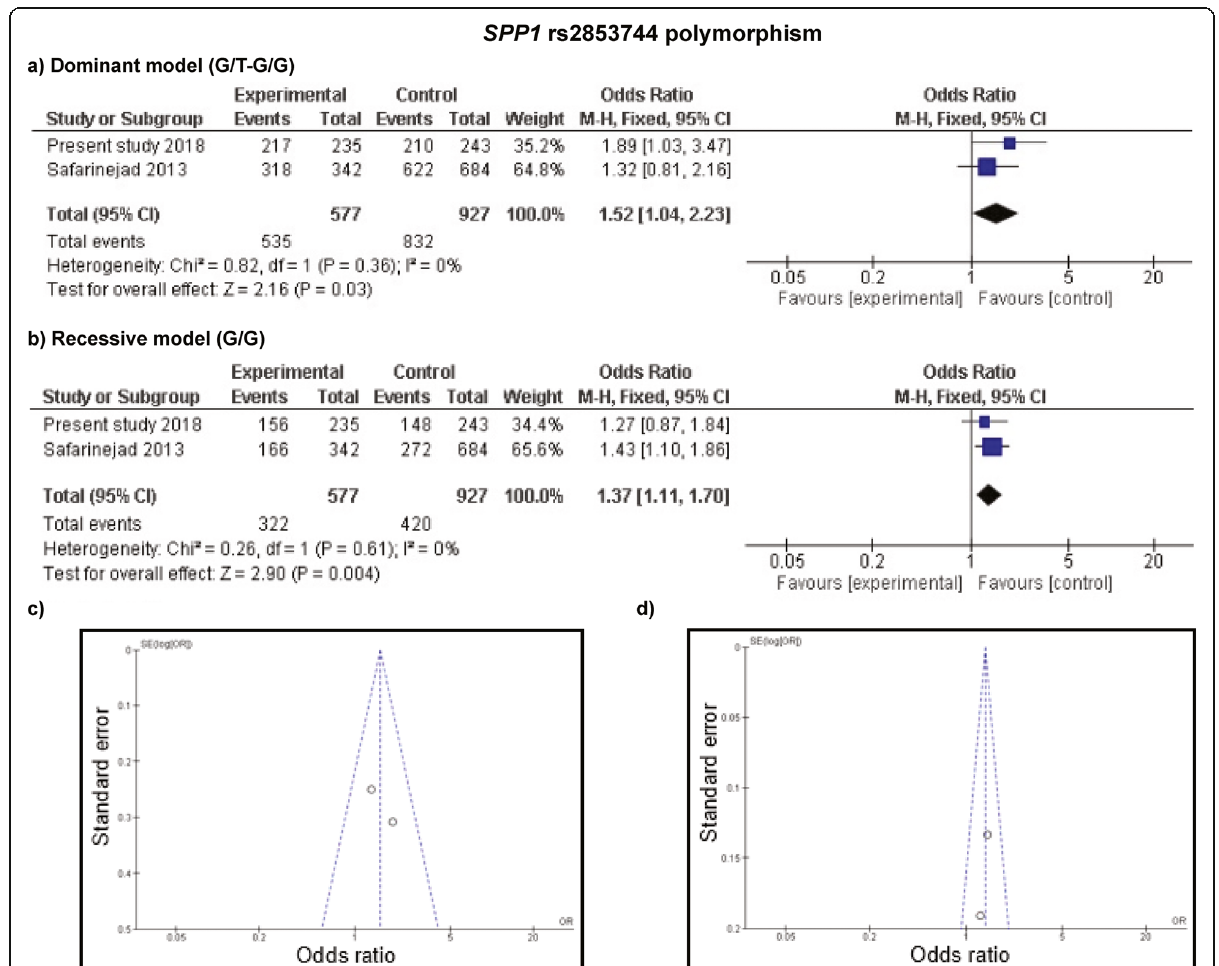
Fig. 2 Meta-analysis of SPP1 rs2853744:G > T polymorphism with risk of urolithiasis. a and b Forest plots of urolithiasis association with rs2853744 polymorphism assuming dominant and recessive model, respectively. c and d Funnel plots of rs2853744 polymorphism in dominant and recessive inheritance, respectively, using fixed effect